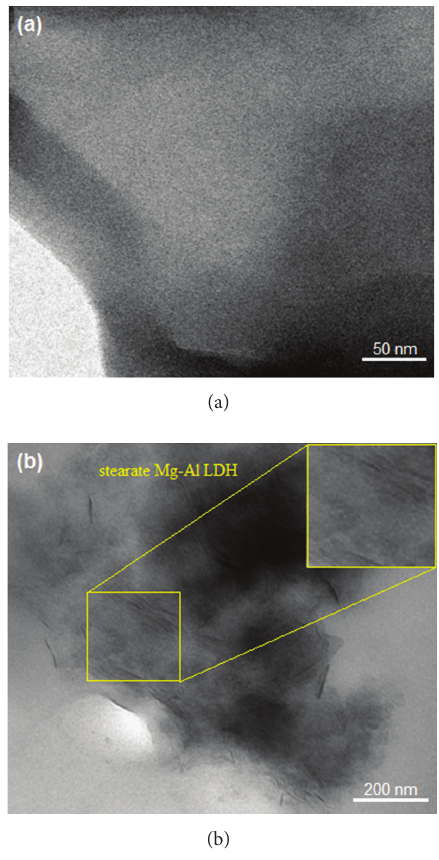
Figure 5: Transmission electron micrographs of (a) 80PHB/20PCL blend and (b) 80PHB/20PCL/1wt% stearate Mg-Al LDH nanocom- posites.